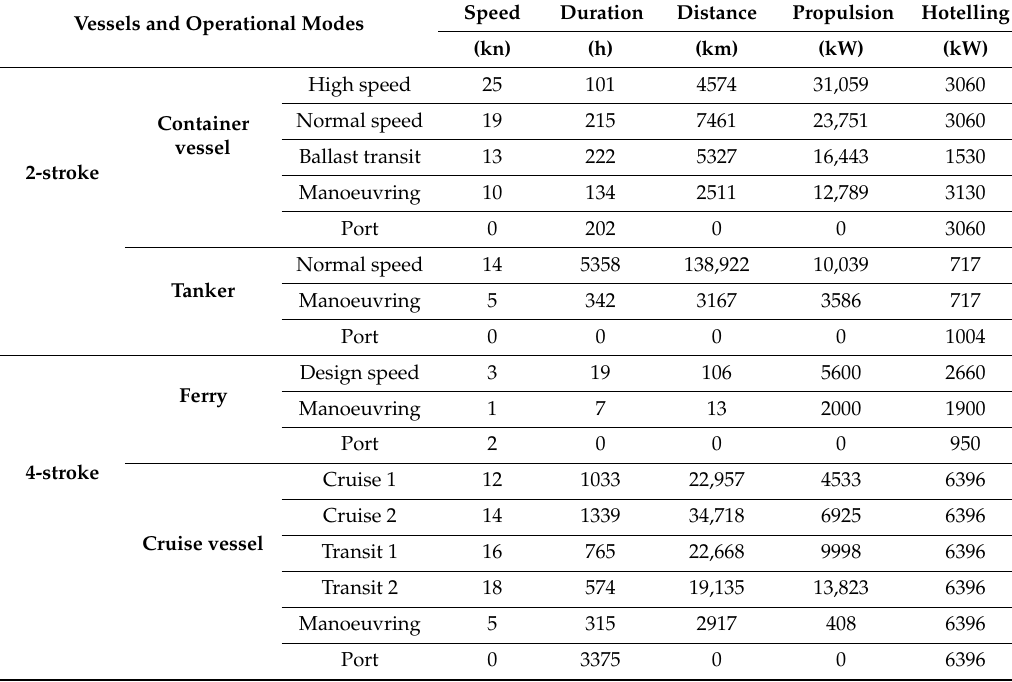
Table 4. Operational profiles of investigated